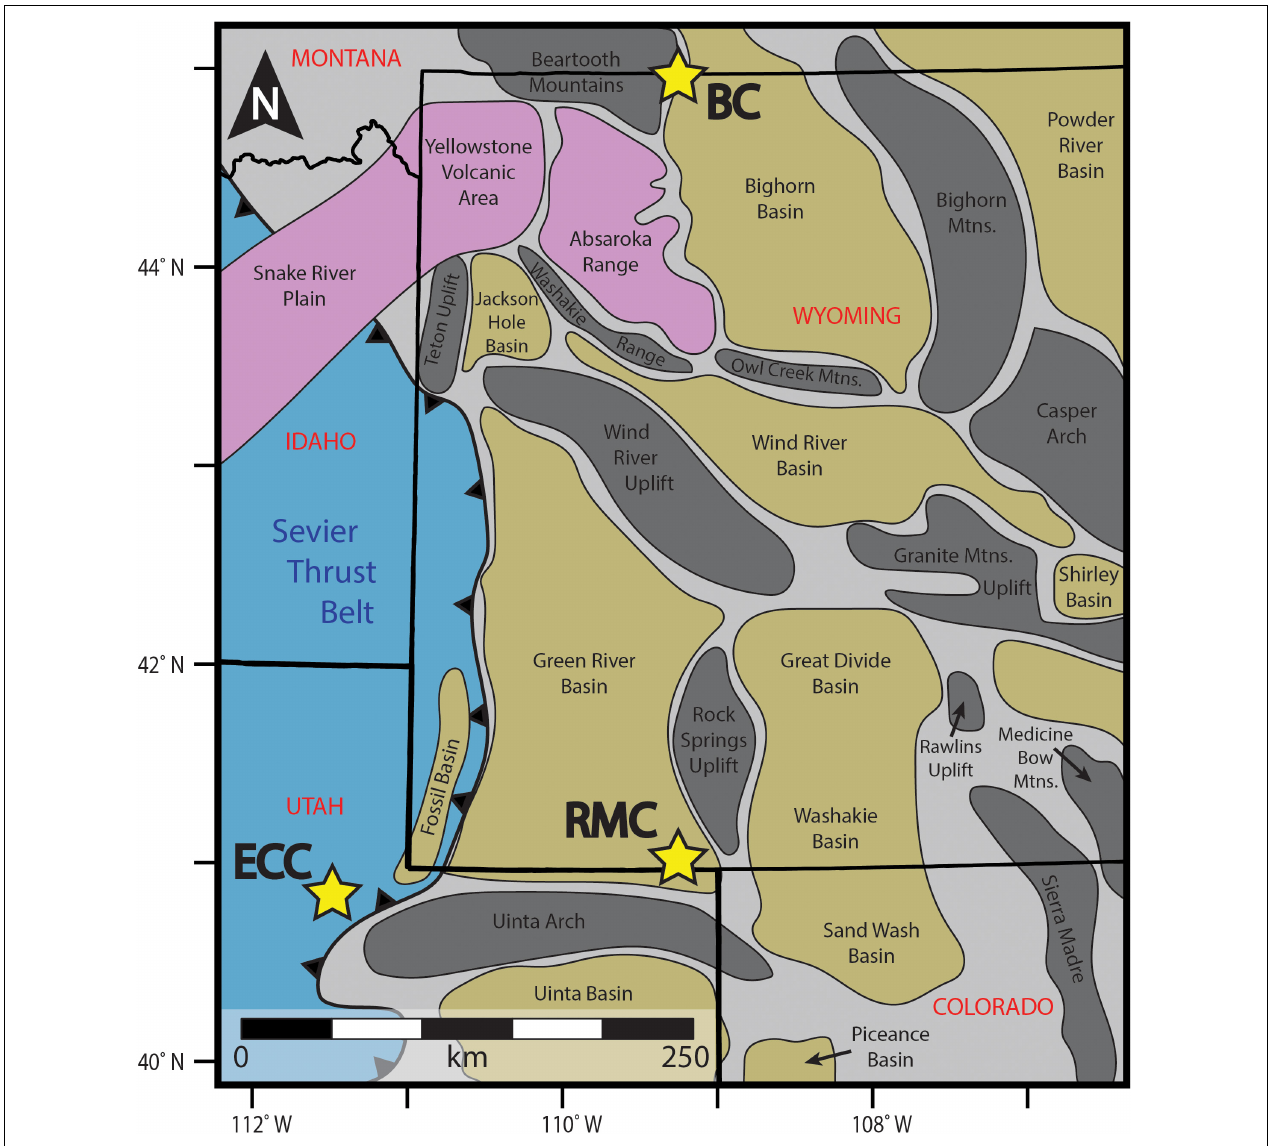
FIGURE 2 | Surface locations of major structural features in the region surrounding the study areas. Locations of the Echo Canyon Conglomerate (ECC), Richards Mountain Conglomerate (RMC), and Beartooth Conglomerate (BC) are marked by stars. The Echo Canyon Conglomerate was shed from the Sevier Thrust Belt while the Richards Mountain Conglomerate and Beartooth Conglomerates were sourced from the Uinta and Beartooth Ranges respectively (both Laramide structures). Modified from Lamerson (1982), Roehler (1992), Smith et al. (2008), and Törö et al.